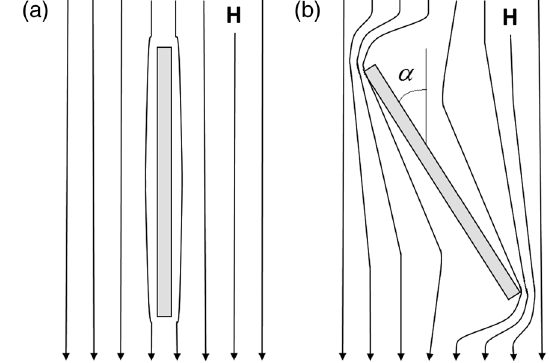
FIG. 14. Schematic representation of magnetic field lines for (a) superconducting sample parallel to the applied magnetic field lines and (b) superconducting sample inclined with angle α